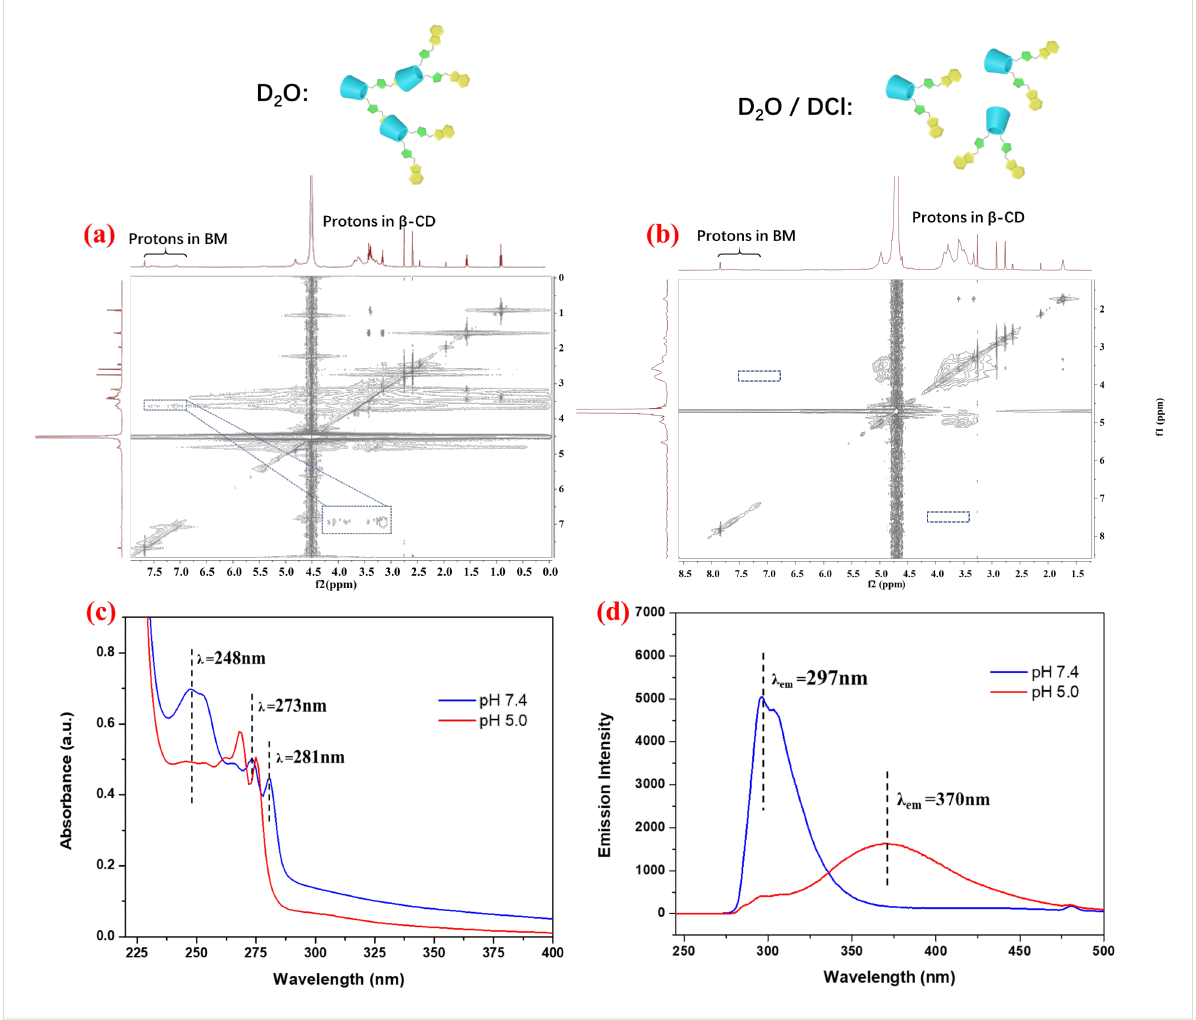
Figure 3: 2D NMR NOESY spectra in D 2 O (a) and D 2 O/DCl (b), UV–vis spectra (c) and fluorescence spectra (d) of β -CD-BM 2 -based supramolecular self-assemblies at pH 7.4 and